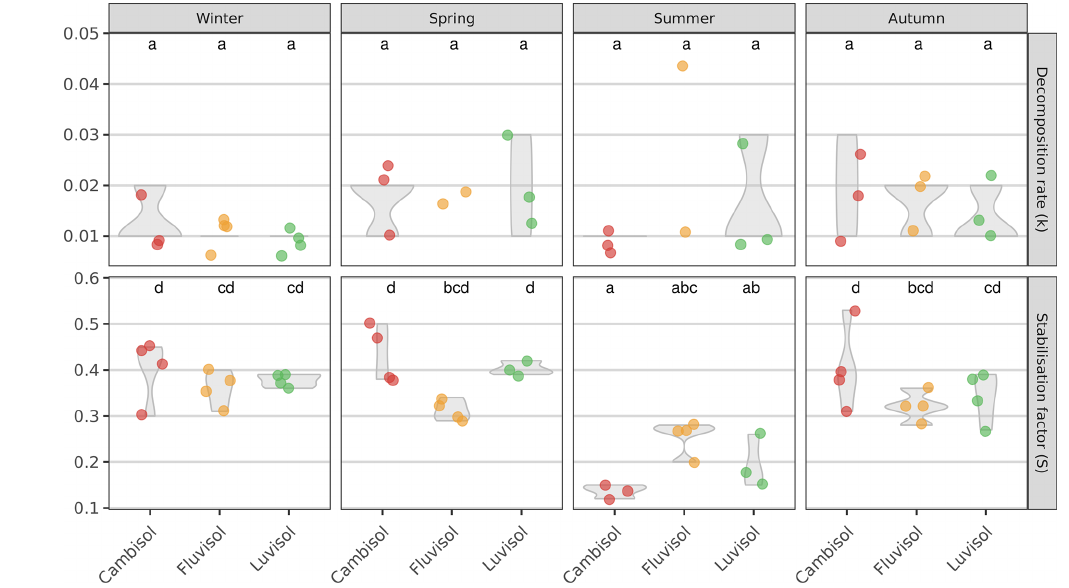
Figure 2. Decomposition rate ( k ) and stabilisation factor ( S ) determined at three sites with different soil types during four seasons. Values shown are averages ( n = 4, lower in case a teabag broke during incubation or in case the rooibos was not in the first phase of decomposition anymore and the main assumptions for calculation of k were violated; thus, k could not be calculated) and the interquartile range (violin shapes). Lowercase letters indicate significant differences between samples (seasons and sites together; p adjusted ≤ 0 .